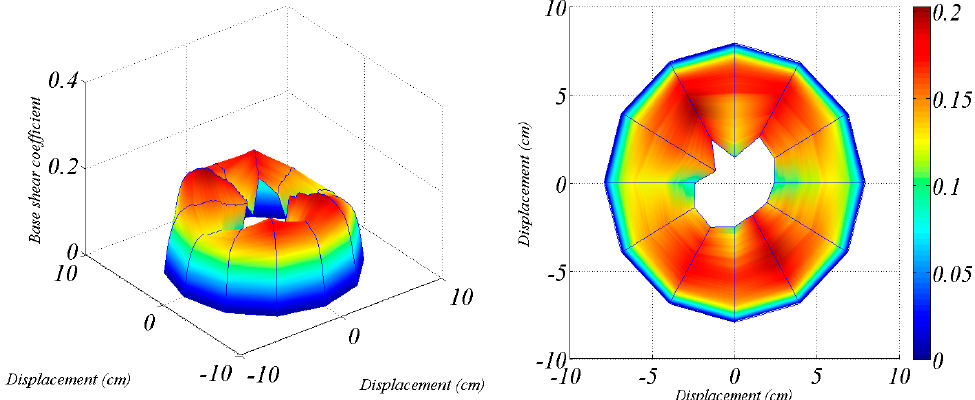
Figure 15. Capacity dominium.